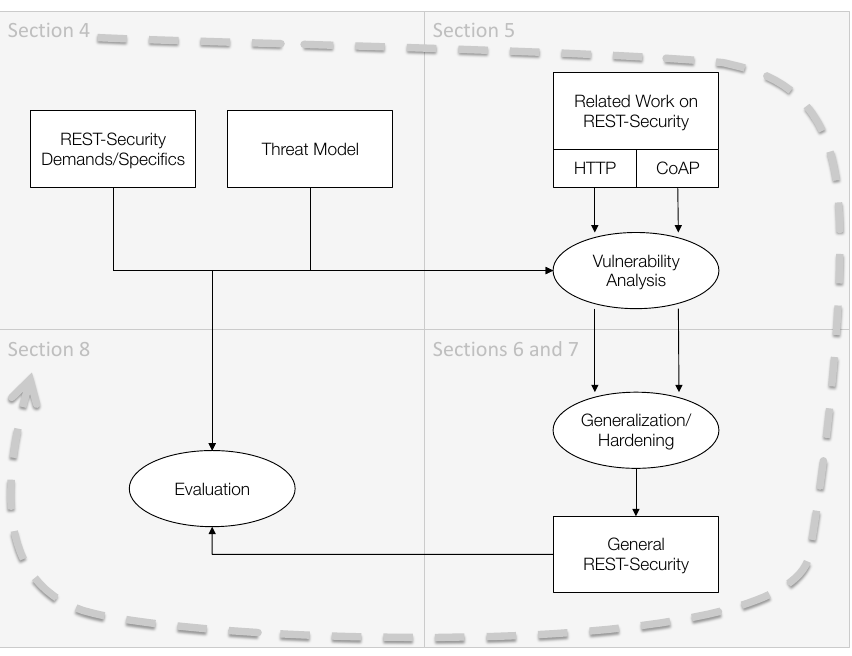
Figure 3. Adopted methodology to derive a general framework for